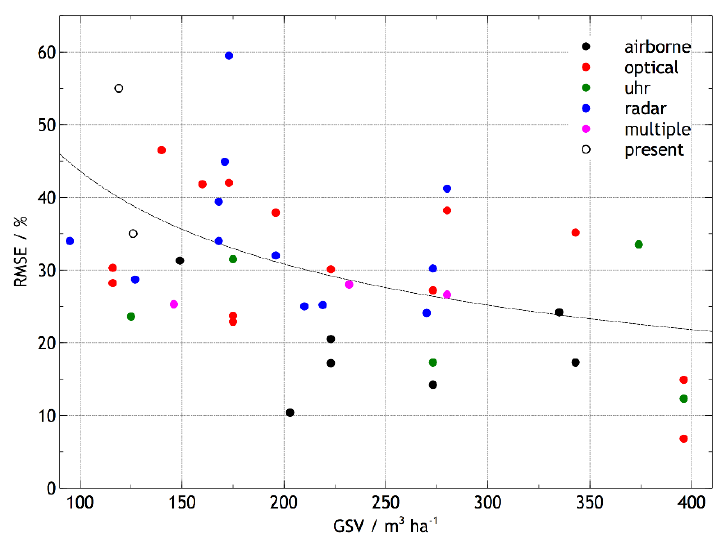
Figure 1. Schematic illustration of the accuracy achieved by remote sensing estimates of GSV, based on a survey of the literature. (See main text for details.) Horizontal axis shows the mean GSV of the plot or plots included in the studies, and the vertical axis shows the estimated error in the calculated GSV expressed as a percentage of the mean. Methods are roughly classified as airborne (using data from ALS (Airborne Laser Scanning) or UAVs), optical (satellite data from Sentinel-2 and Landsat), ultra-high resolution satellite data (with spatial resolution of 1 m or finer), radar (satellite radar data), or ‘multiple’, using more than one data type. ‘Present’ summarises the performance of the method developed in the present work. The dashed line is an empirical fit to the data except for the ‘airborne’ class, and has the formula RMSE = 436 (GSV) −1/2 , where RMSE is in % and GSV in m 3 ha −1 .